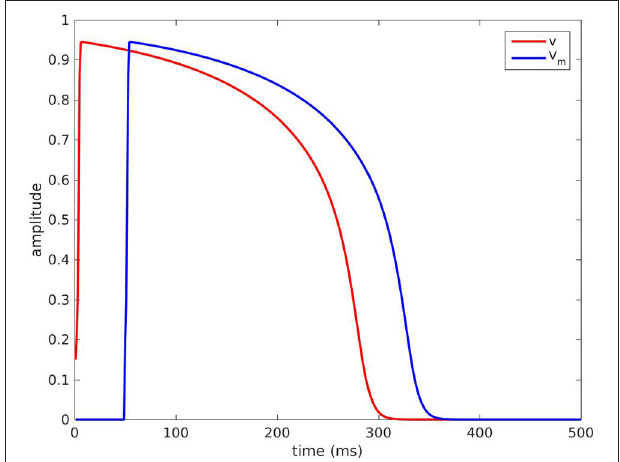
FIGURE 1 | Red curve: voltage v ( P , t ) with the default parameters P . Blue curve: TMP V m ( t ) = v ( P ; t − τ ) with τ = 50 ms .